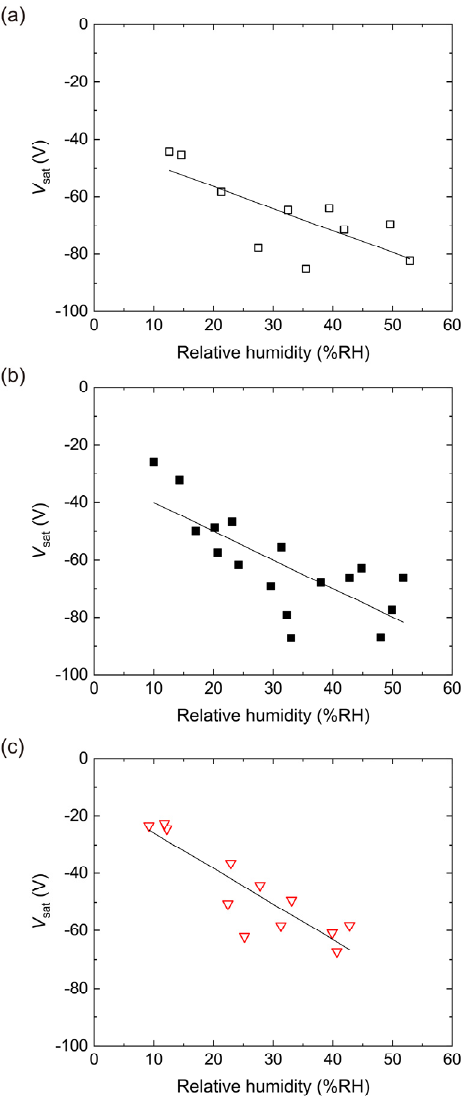
Figure 5. Plots of V sat versus relative humidity for PES films doped with 1 wt% ( a ), 5 wt% ( b ), and 10 wt% ( c ) ANA nanoparticles.